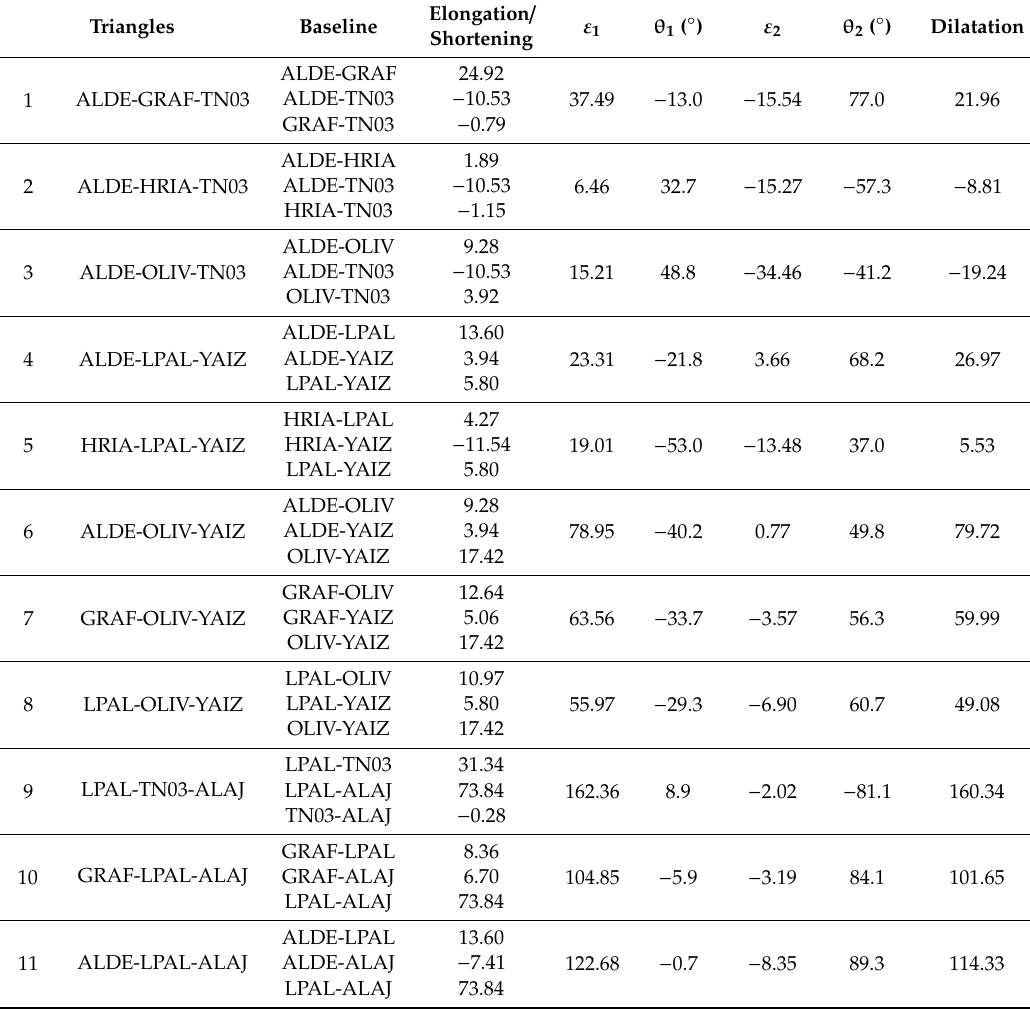
Table 2. Strain parameters calculated for each triplet of GNSS stations: elongation, shortening, principal strains ε 1 , ε 2 and their respective principal directions θ 1 , θ 2 , and dilatation. The strain and elongation / shortening units are 10 − 9